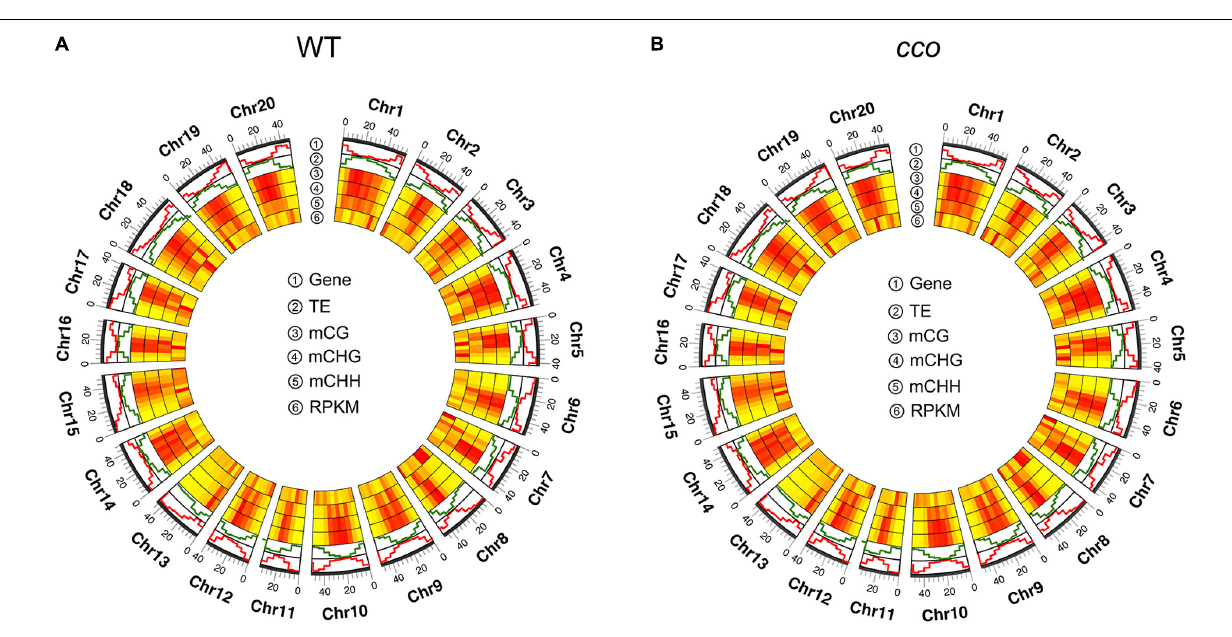
FIGURE 3 | A circle plot of gene density, transposon density, DNA methylation level, and the transcript level for the WT (A) and the cco mutant (B) . Gene indicates “gene density;” TE indicates “transposon density;” mCG, mCHG, and mCHH indicate the methylated cytosine level in each context, respectively; RPKM (reads per kilobase million) indicates “gene expression level.” Data was plotted in 5-Mb windows on all soybean chromosomes. Bars with color from yellow to red indicate the methylation level or gene expression level from low to high, respectively. Pictures were drawn by